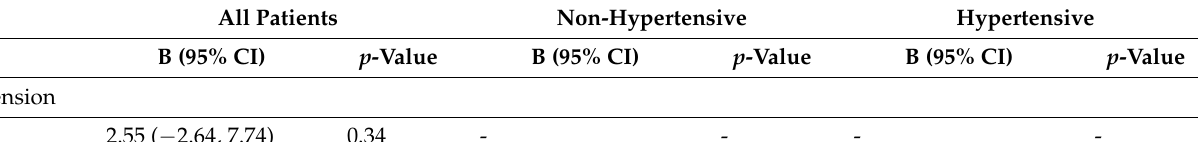
Table 4. Factors Associated with